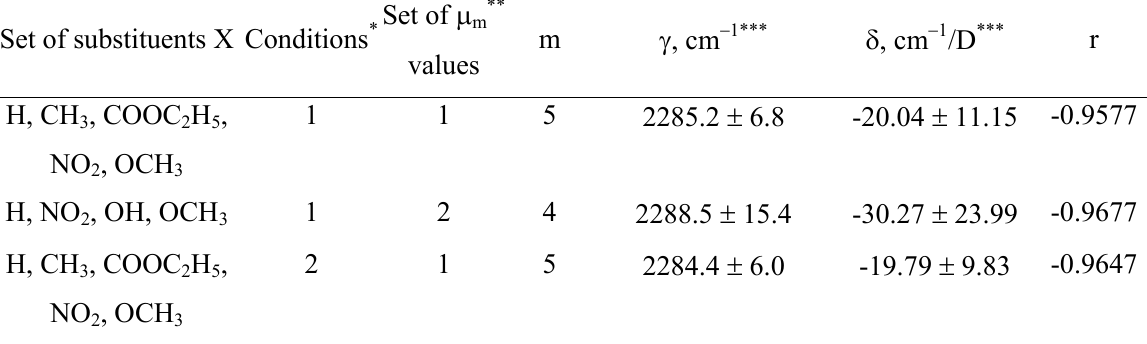
Table 4h. Correlations of stretching vibrational frequencies ( ν ) for fragment C-N + ≡ N bonds in